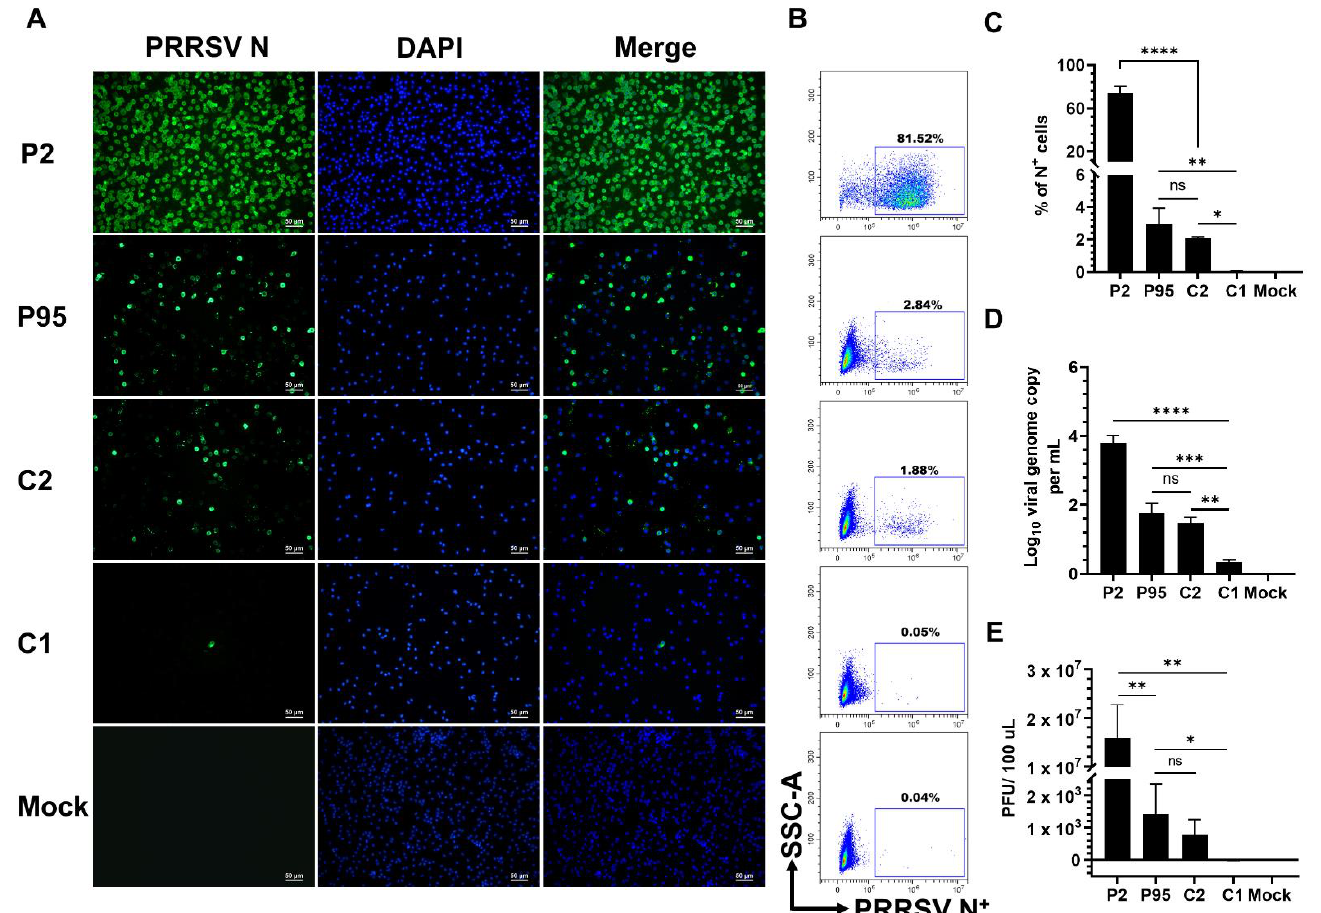
Figure 1. Infectivity of NCV1 P95 and its derived clones in PAMs at low MOI. PAMs collected from four piglets were inoculated with the indicated viruses at an multiplicity of infection (MOI) of 0.1 tissue culture infectious dose 50 (TCID 50 ) per cell. All data were collected at 24 hpi. ( A ) Representative images of cells that were fixed and stained with an anti-N antibody to visualize virus-infected cells (green color). DAPI was used to stain the nuclei (blue color). Scale bar = 50 µ m. ( B ) Representa- tive flowcytometry plots of PAMs that were fixed and stained with a FITC-labeled anti-N antibody. Uninfected cells were used to set-up gating. ( C ) Percentage of PAMs expressing N protein (N + ) as quantified by flowcytometry. ( D ) Difference of viral genome copy numbers in the culture superna- tants collected at 0 hpi and 24 hpi as quantified by RT-qPCR. ( E ) Difference of virus infectious titers in the culture supernatants collected at 0 hpi and 24 hpi as quantified by plaque assay in MARC-145 cells. Data are presented as means and SEM of the three independent experiments each of which involved four populations of PAMs collected from four different pigs. ns: non-statistically signifi- cant, * p < 0.05, ** p < 0.01, *** p < 0.001, **** p < 0.0001.